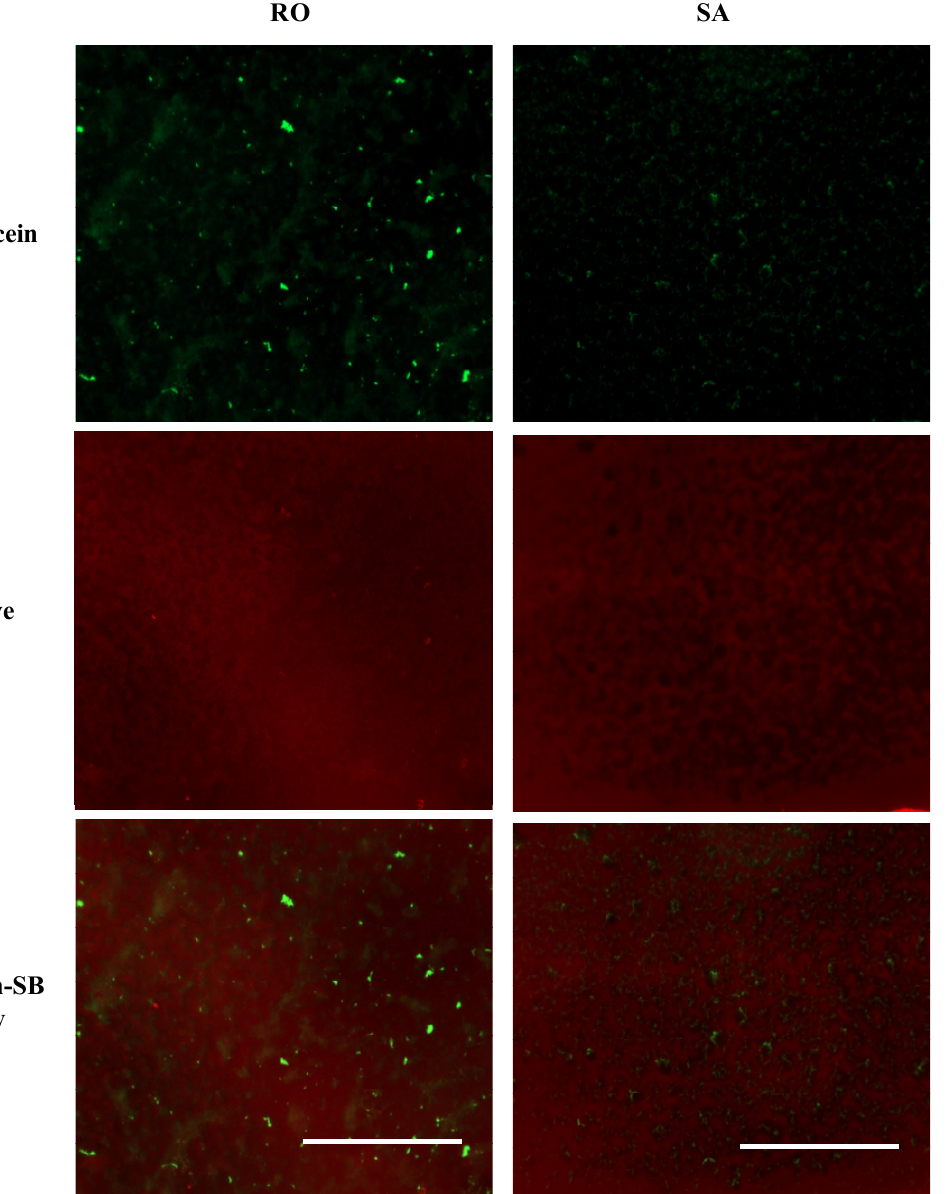
Figure 8. Representative FM images of chitosan (CHI)/hyaluronan (HA)/fluorescein (6-FAM) DNA multilayer films exposed to 200 µM SB dye showing co-localization (Fluorescein-sulforhodamine B (SB) overlay; orange) of DNA (Fluorescein; green) and SB dye (SB dye; red) fluorescence as an indication of binding. Films contain either RO DNA (left) or sulforhodamine B aptamer (SA) DNA (right). Films were prepared using the modified method of deposition. Scale bar, 400 µm. RO